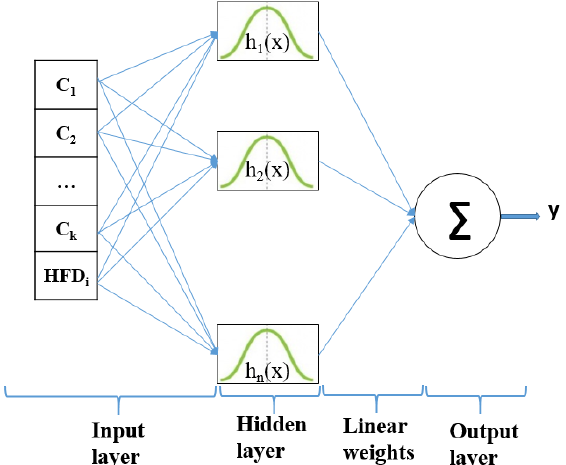
Figure 5. The structure of an RBFNN classifier.